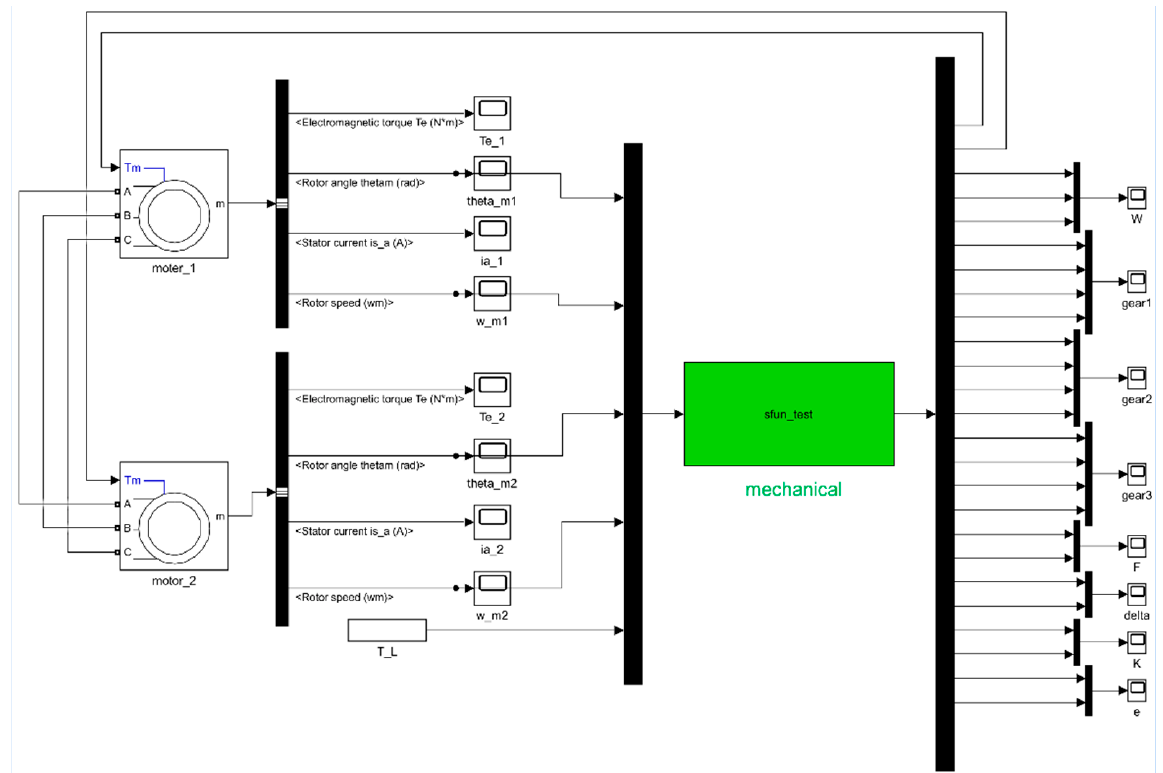
Figure 8. Simulink block diagram of electromechanical system.